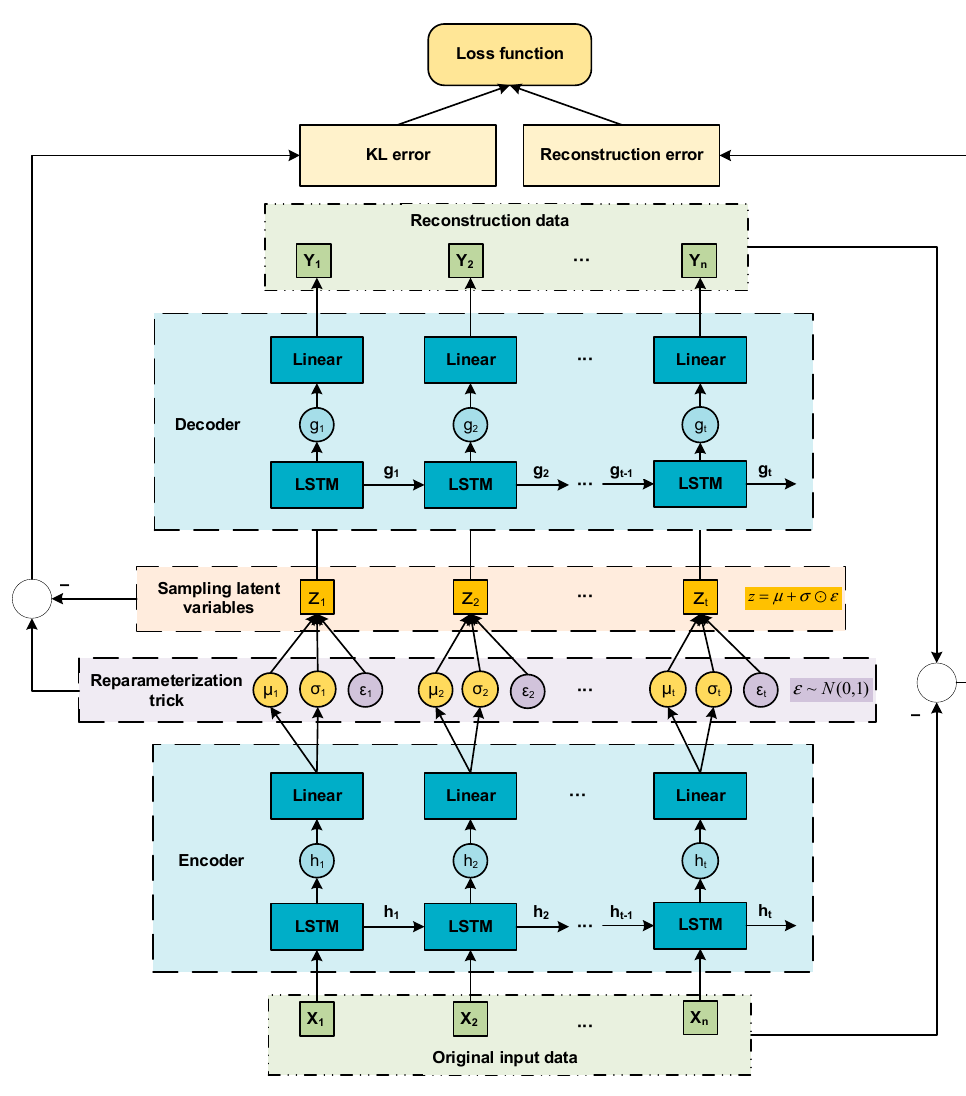
Figure 2. VAE structure diagram.